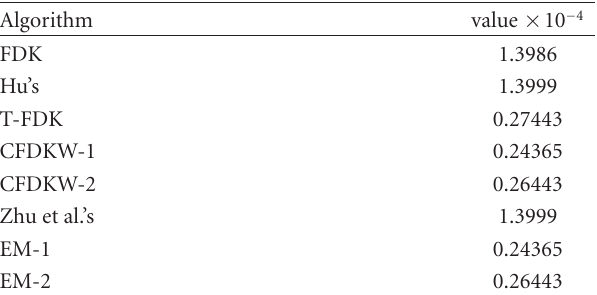
Table 1: Variance of the noisy images in Figure 13 based on the noise-free images in Figure